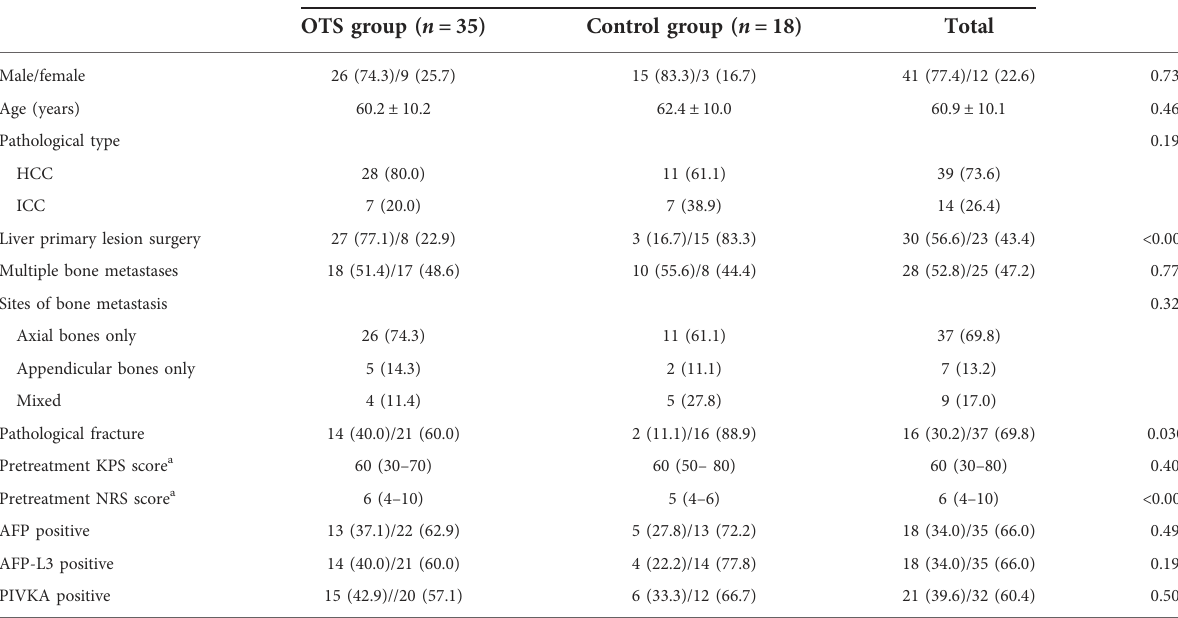
TABLE 1 Clinical characteristics of patients with bone metastasis of liver cancer.